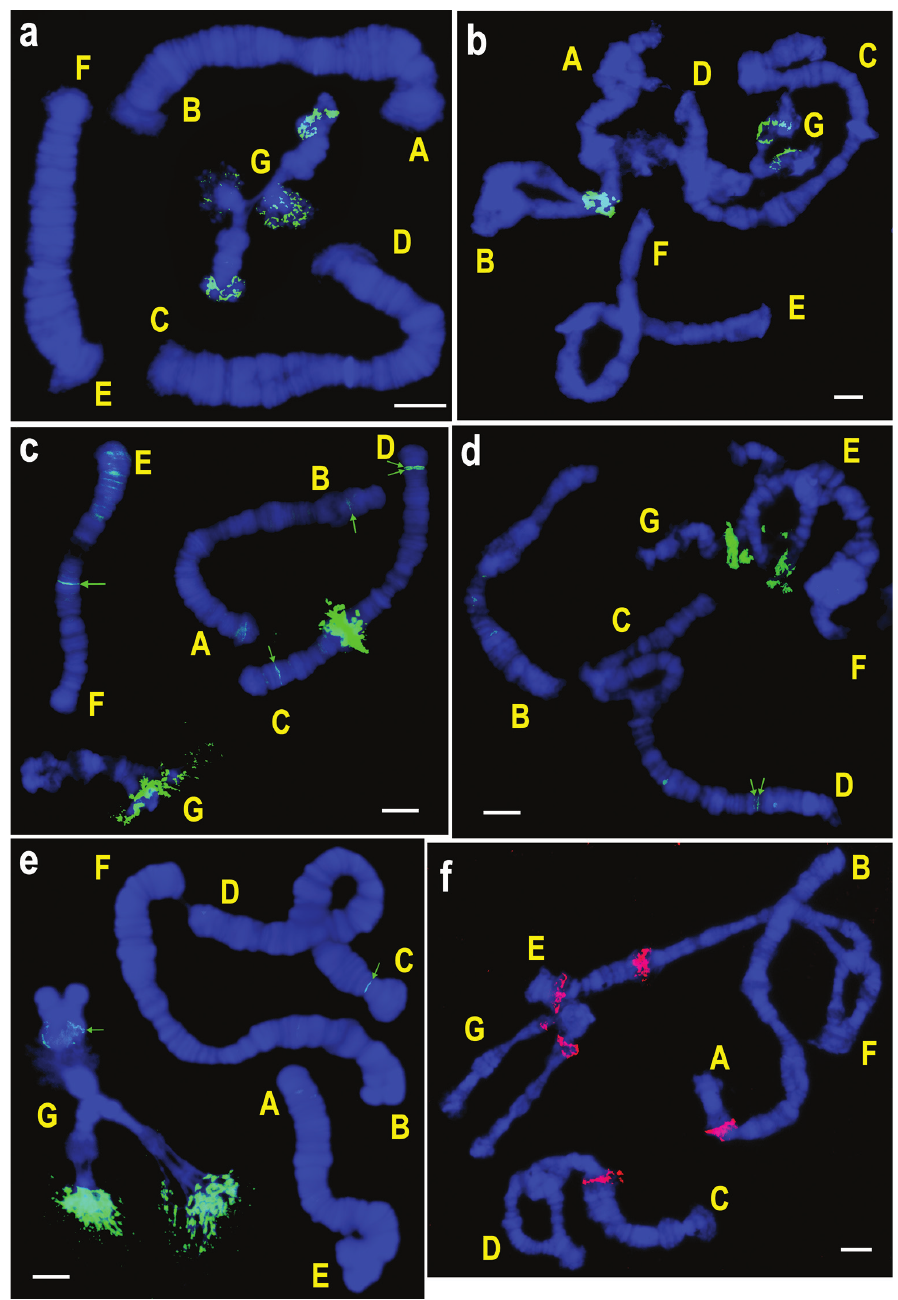
Figure 3. FISH of rDNA probes on polytene chromosomes of species from the subgenus Chironomus with multiple localization of hybridization sites. a Ch. agilis b Ch. cingulatus c Ch. muratensis d Ch. nudi- ventris e Ch. pseudothummi f Ch. “annularius”. Letters designate chromosomal arms. Green arrows show sites of weak hybridizations signals. Bar = 10